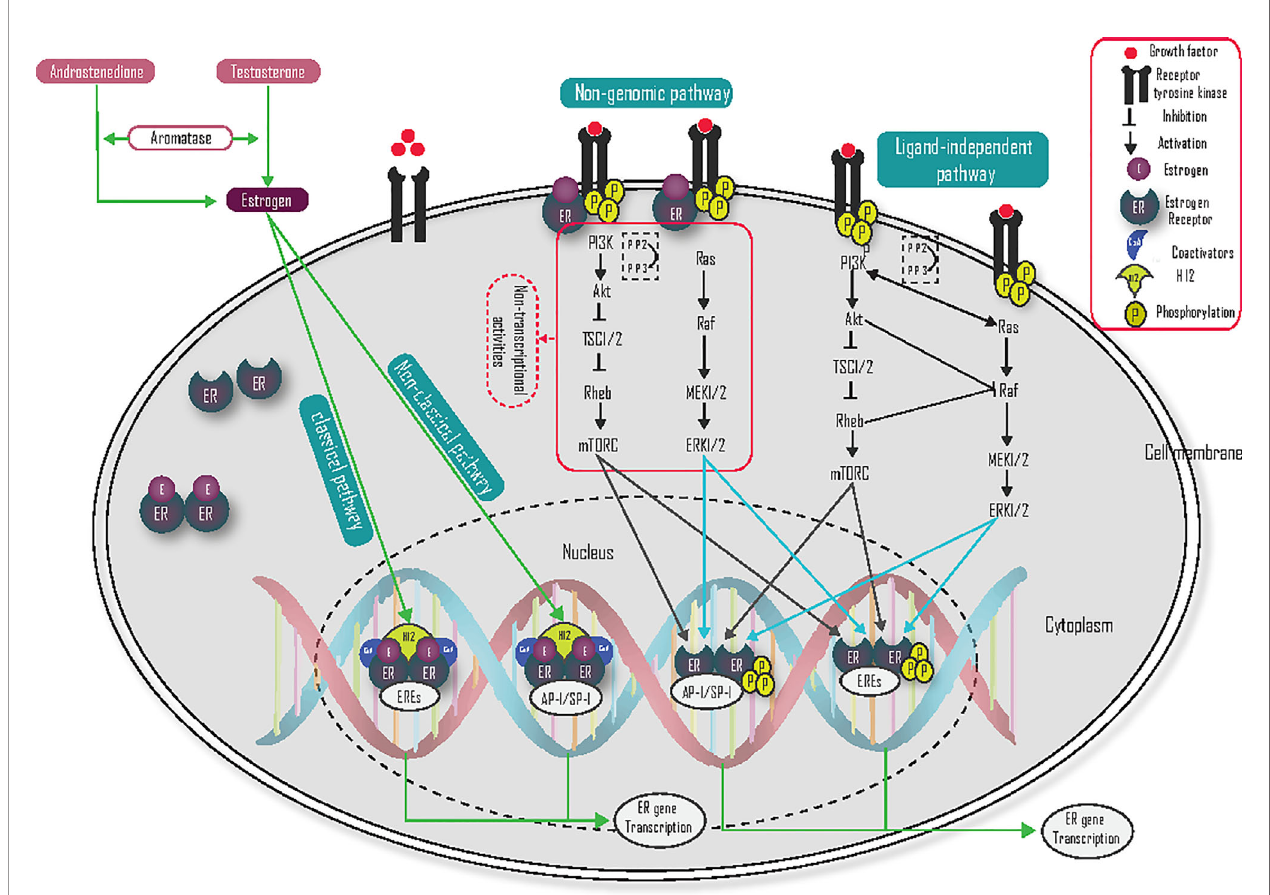
FIGURE 2 | Ligand-dependent and ligand-independent mechanism of action of the estrogen